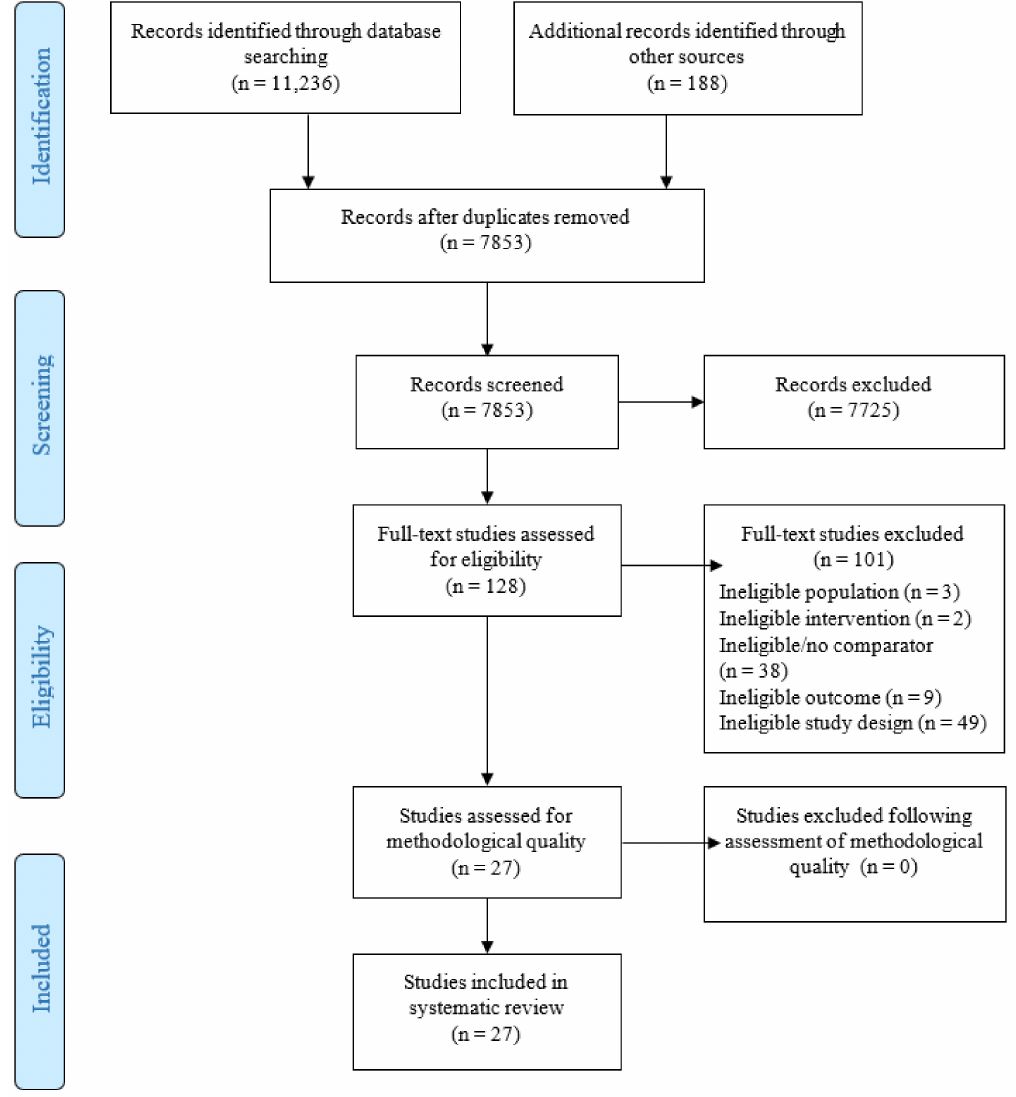
Figure 1. PRISMA flow diagram of search results and study selection process for published studies, 1990–2017. Note: PRISMA = Preferred Reporting Items for Systematic Reviews and